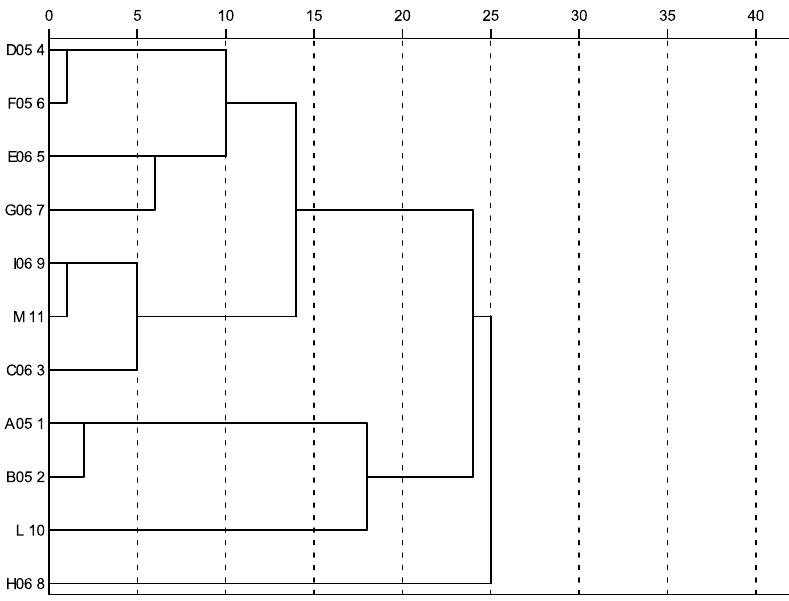
Figure 2. Dendrogram of the honey samples (ordinate), based on physicochemical measurements, total phenolic contents and radical scavenging activity (RSA). The similarity level is represented on the